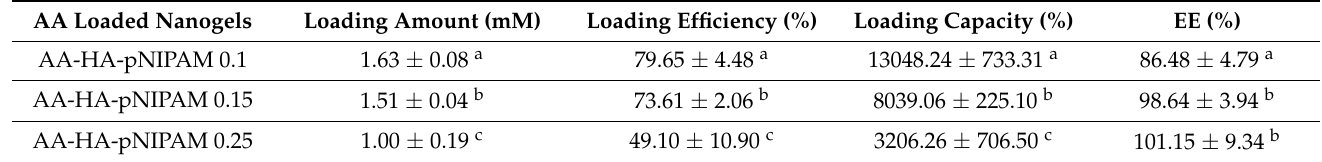
Table 2. Loading amount, loading efficiency, loading capacity and EE of the nanogel formulations (mean ± SD, n = 3) # . AA Loaded Nanogels Loading Amount (mM) Loading Efficiency